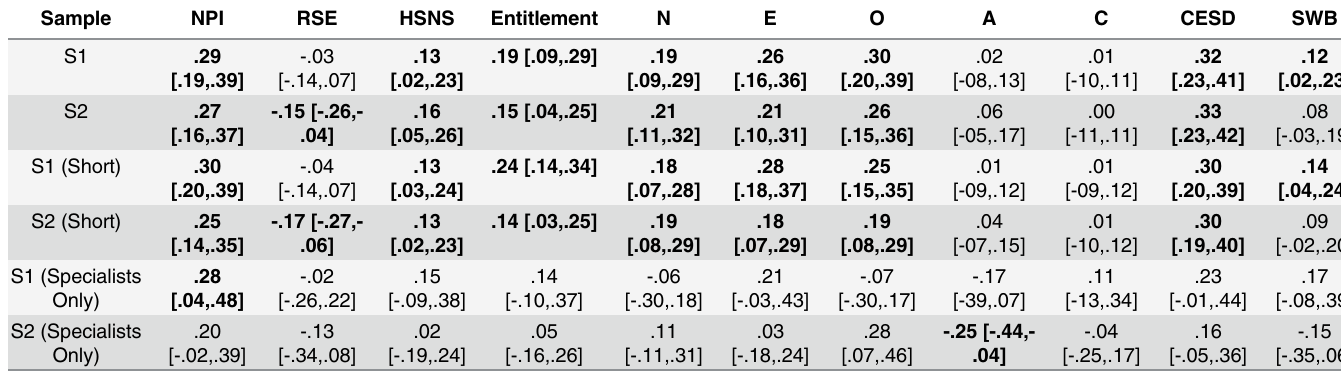
Table 3. Correlations between GCES (full and short form) and Personality Measures in Samples 1 and 2.